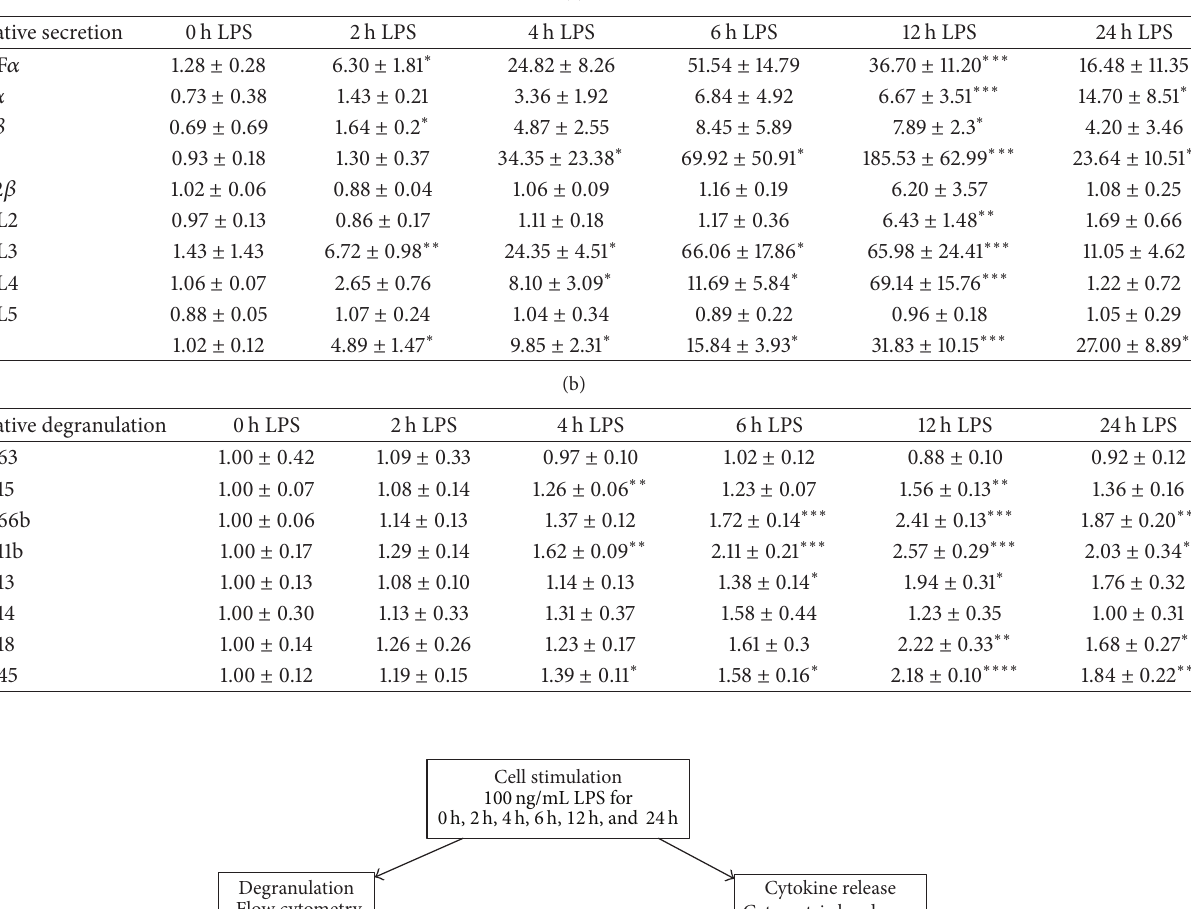
Table 2: Time-dependent (a) secretion of cytokines and (b) granules expressed in ratio between LPS-stimulated and nonstimulated cells ± SEM of at least 3 independent experiments, significantly different from nonstimulated control at the same time point: ∗ 𝑝 < 0.05 , ∗∗ 𝑝 < 0.01 , ∗∗∗ 𝑝 < 0.001 , and ∗∗∗∗ 𝑝 < 0.0001 .